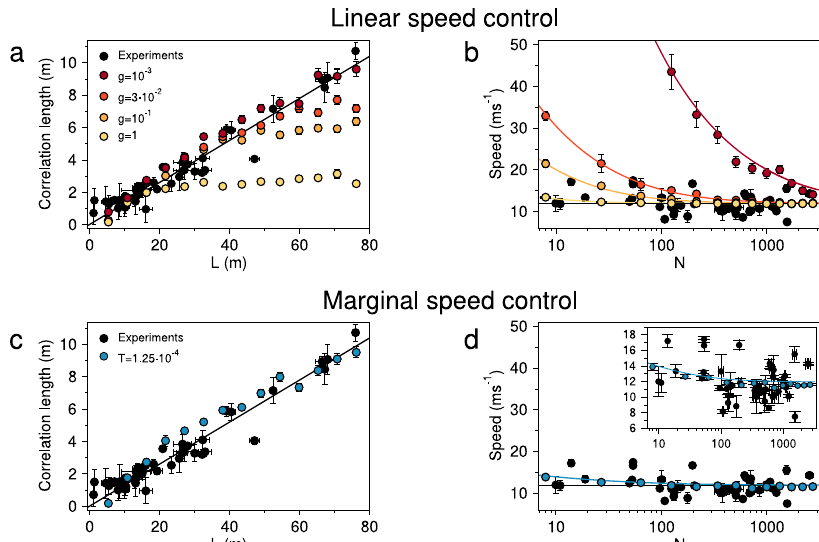
Fig. 3 Linear vs. Marginal speed control. a Natural fl ocks show a clear scale-free behaviour of the speed correlation length, ξ sp , which scales linearly with L (Pearson coef fi cient r P = 0.97, p < 10 − 9 ). SPP simulations with linear speed control yields scale-free correlations over the entire range of L only at the smallest value of the stiffness g (dark red). b Natural fl ocks show no detectable dependence of their mean speed on the number of birds in the fl ock (Spearman coef fi cient r S = − 0.13, p = 0.21; the black line is the average over all fl ocks). SPP simulations with linear control give a near-constant speed compatible with experiments only at the largest value of the stiffness g (light yellow); coloured lines represent the theoretical prediction of Eq. (6). Linear speed control is therefore unable to reproduce both experimental traits at the same time. c The correlation length in SPP simulations with marginal speed control scales linearly with L over the full range, provided that the temperature/noise T is low enough to have a polarization equal to the experimental one. d At the same value of the parameters as in panel c , SPP simulations with marginal control give mean group ’ s speed very weakly dependent on N , fully compatible with the experimental data; the y scale of the main plot is set to make a comparison with panel b , while in the inset we report the same data over a smaller y range to appreciate the agreement between theory (blue line) and simulations, and to show that the trend of group ’ s speed with N of the marginal model is really weak. [Each length scale ℓ pertaining to numerical simulations is reported in meters by normalizing it to the inter-particle = r (cid:5) Þ , where r exp distances, ‘ ¼ ‘ (cid:5) ð r exp and r (cid:5) are the mean inter-particle distances of experiments and simulations respectively. Numerical and 1 1 1 1 experimental correlation lengths are reported on the same scale by matching the curves at the scale-free value of the parameters; numerical and experimental speeds are reported on the same scale by matching the curves at the largest value of N . Coloured points correspond to averages over numerical data, error bars to standard deviations. Black points correspond to the median (over time) of experimental data for each individual fl ocking event, error bars to median absolute